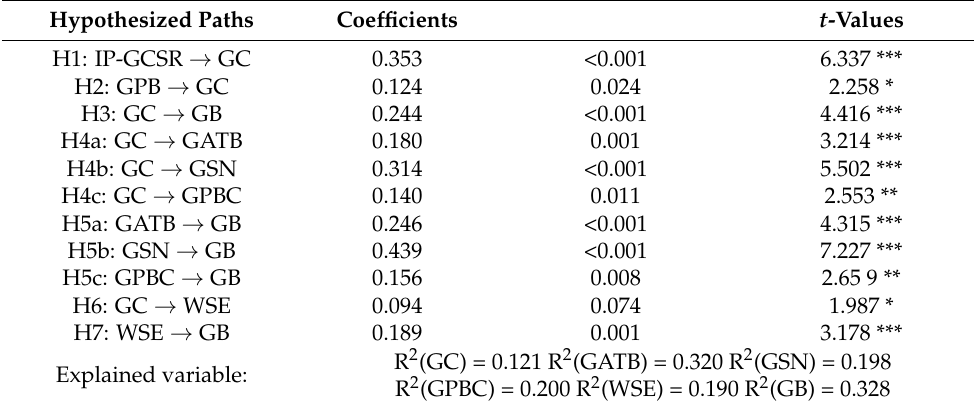
Table 2. Structural model results and hypothesis testing.